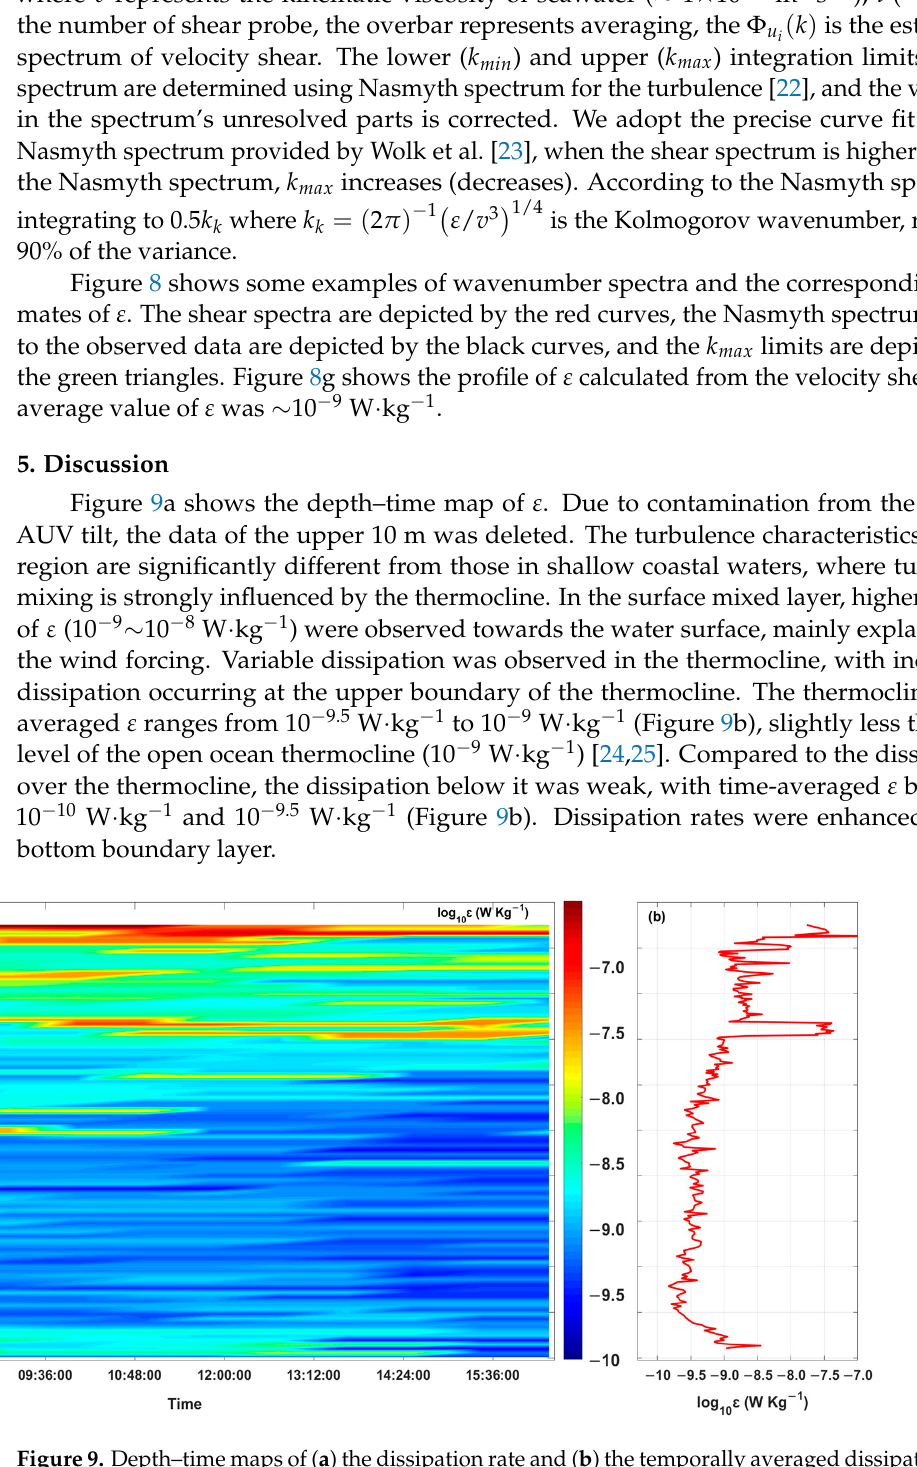
Figure 9. Depth–time maps of ( a ) the dissipation rate and ( b ) the temporally averaged dissipation rate.